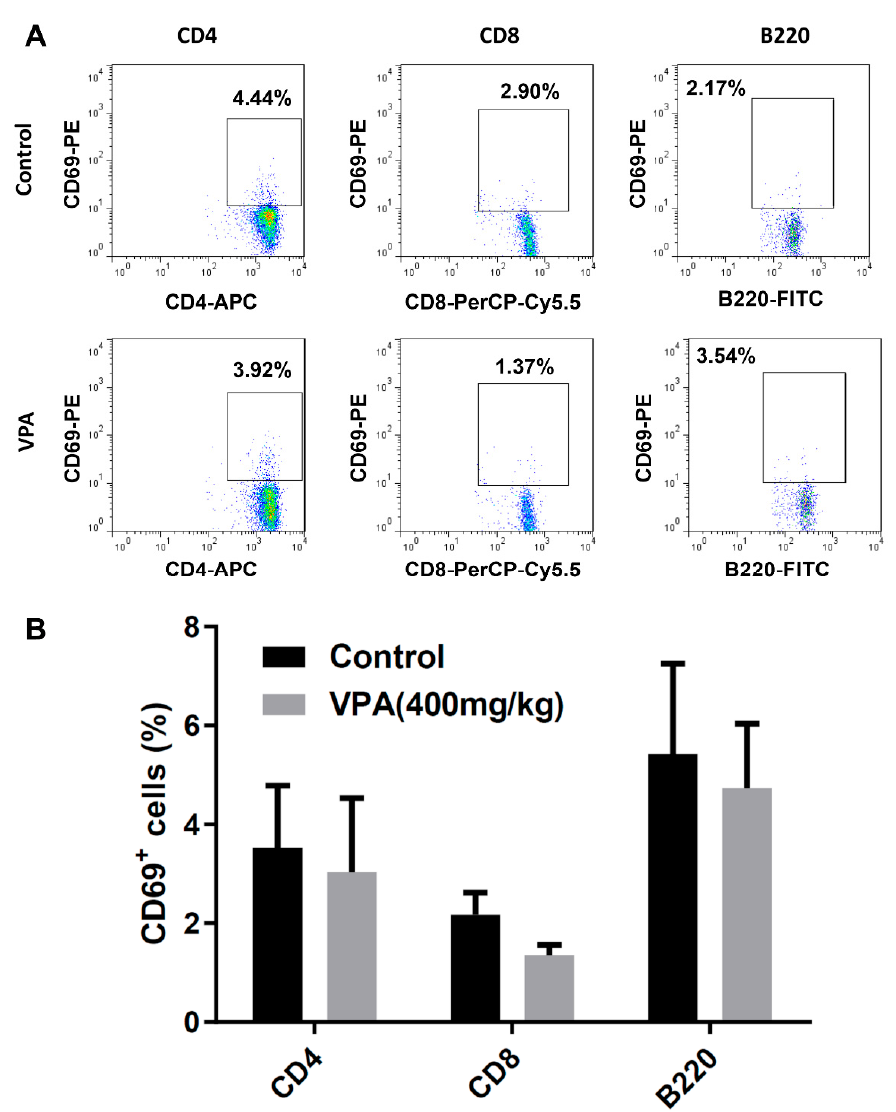
Figure 4. The effect of VPA treatment in the activation of lymphocyte in NOD recipients. ( A ) Representative plot of the expression of CD69 in CD4 or CD8 T cells and B cells (B220). ( B ) There was no significant difference in the percentage of CD69 in the CD4, CD8 T cells or B cells.